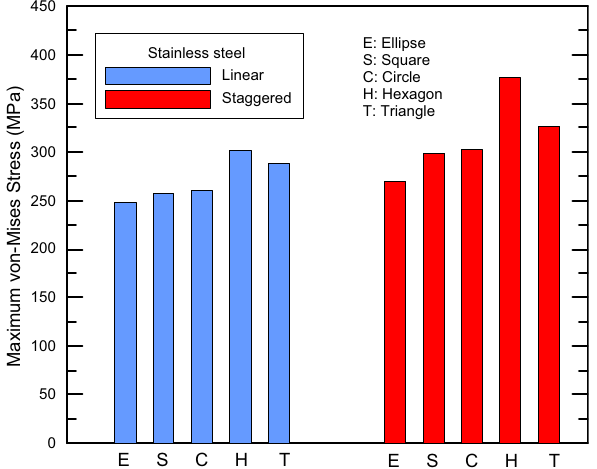
Figure 6: Maximum stress distribution depending on hole geometry in the linear and staggered arrangement of the stainless - steel per - forated